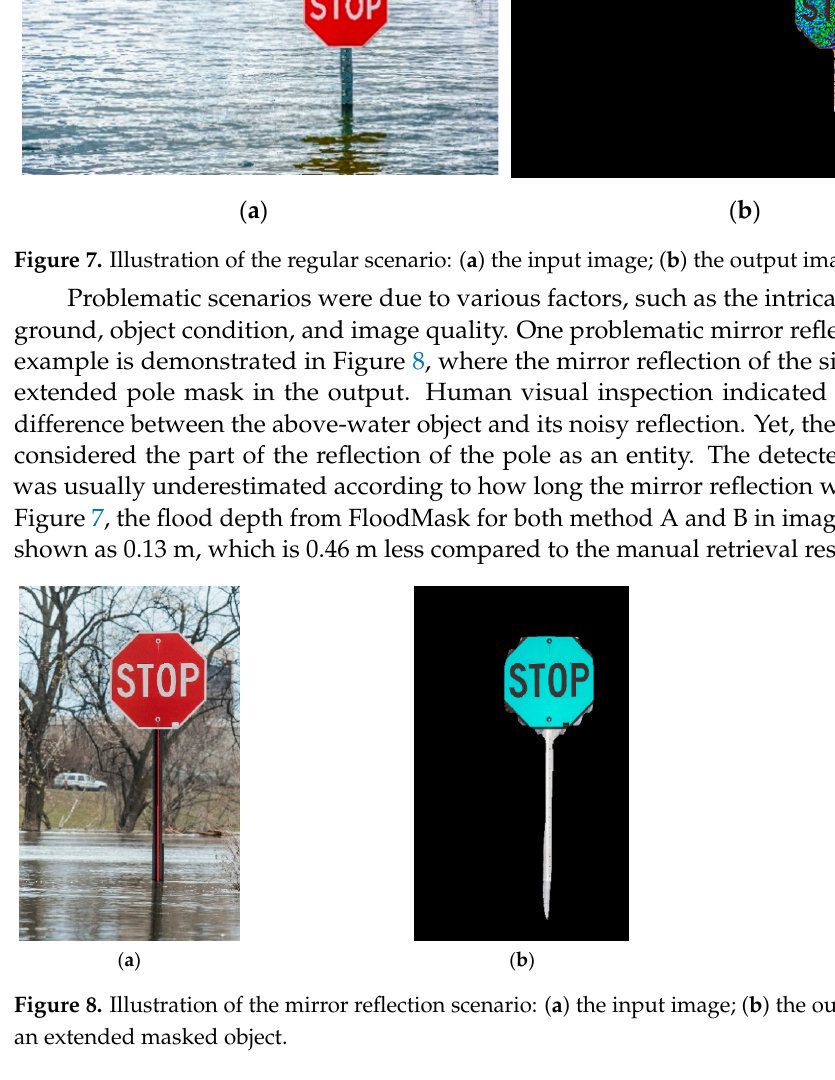
Figure 8. Illustration of the mirror reflection scenario: ( a ) the input image; ( b ) the output image with an extended masked object. Results from the multi-object scenarios are shown in Figure 9. What stands out in Figure 9a is that there is an extra sign beneath the stop panel. It can be seen from Figure 7b that the stop panel was successfully detected, and the rectangular text was also partly